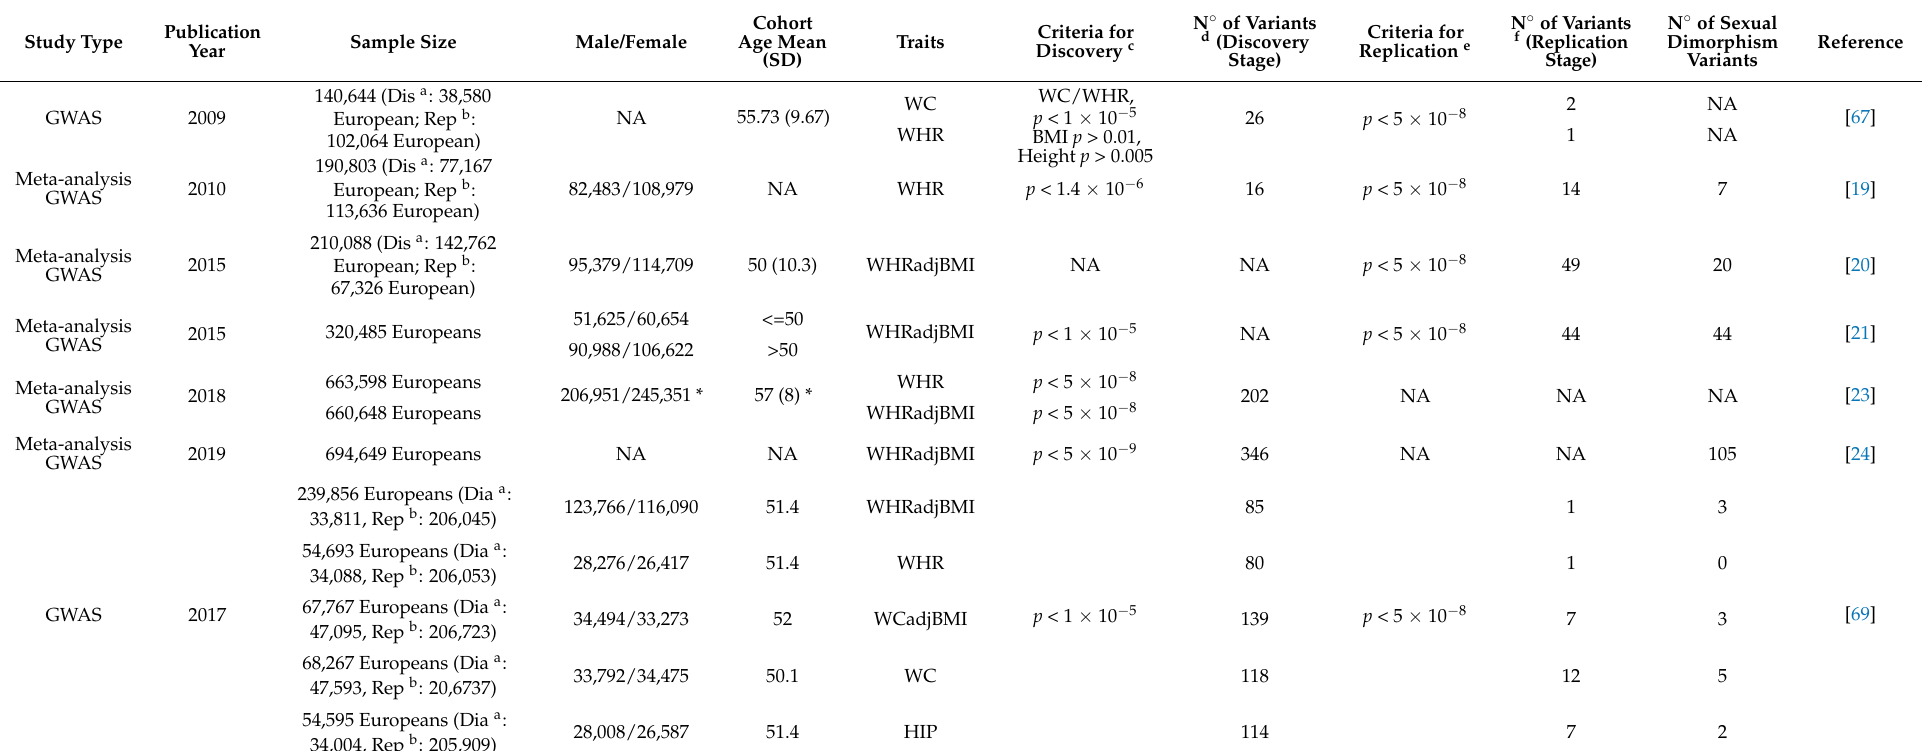
Table 1. Studies conducted in a European